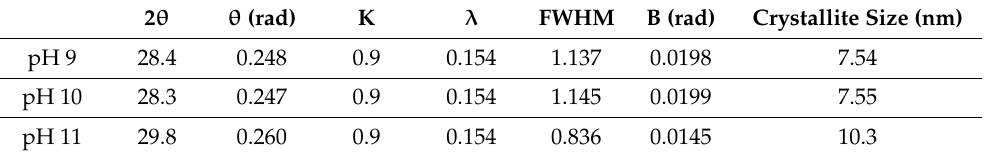
Table 1. Comparison of the crystallite size for the NPs based on XRD